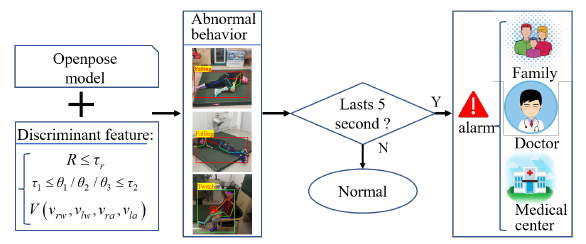
Fig. 1. Flow chart of abnormal behavior detection and alarm.